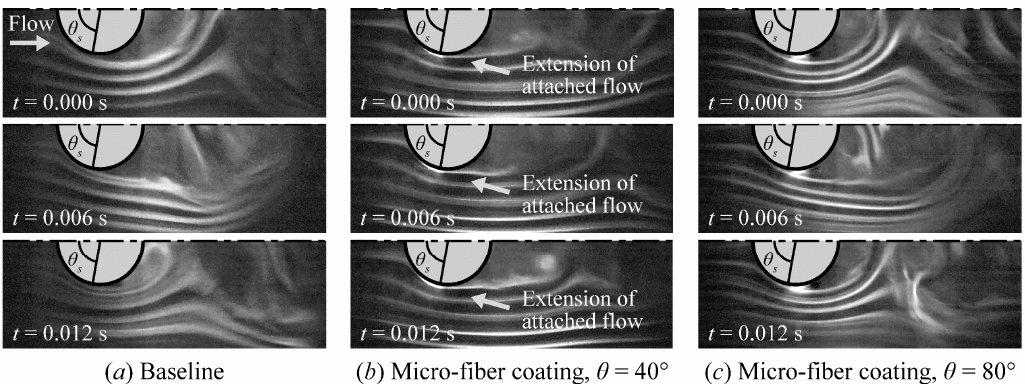
Figure 4. Time series of the flow filed around the cylinder by smoke flow visualization. Comparison of wake flow for ( a ) baseline and ( b ) micro-fiber coating at θ = 40°, and ( c ) micro-fiber coating at θ = 80°.